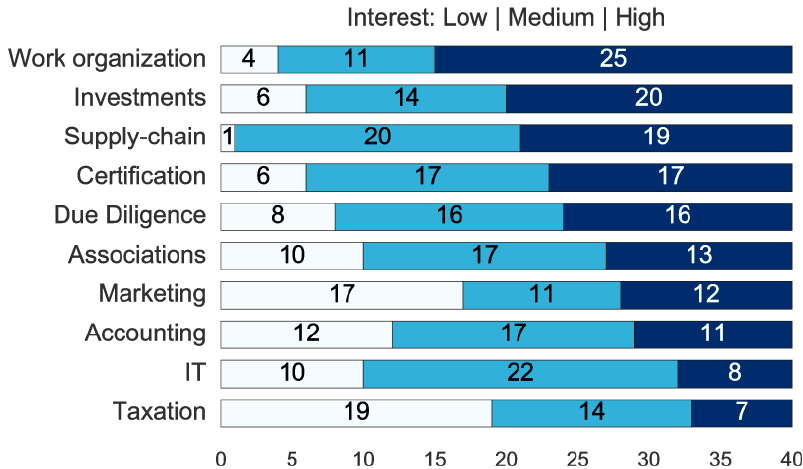
Figure 2. Connections between interests ( a ) and between classes ( b ) (in percentages).